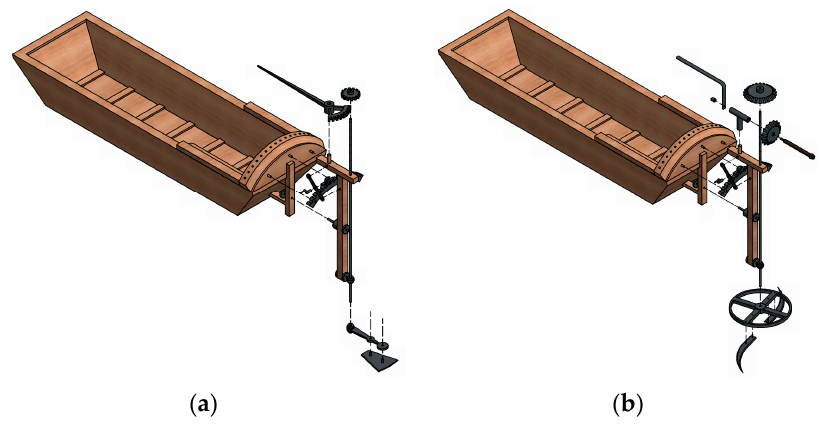
Figure 3. Exploded view of the 3D model. ( a ) single blade; ( b ) double blade.